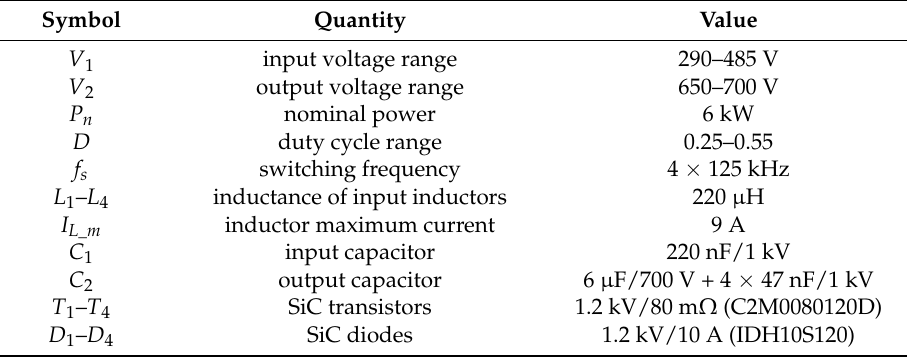
Table 1. Converter